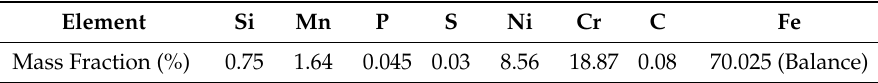
Table 2. Geometric and working angels.